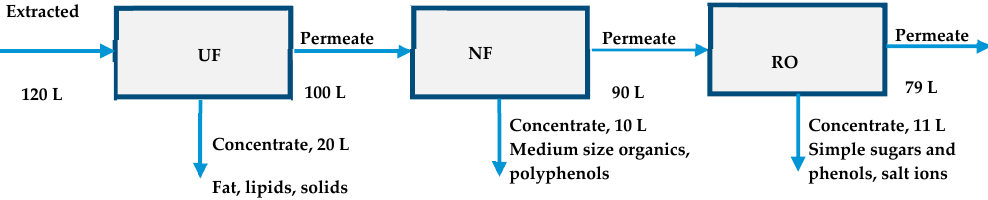
Figure 1. Schematic diagram of the feed, permeate and concentrate streams during the pilot scale experiment. UF: ultrafiltration; NF: nanofiltration; RO: reverse osmosis.